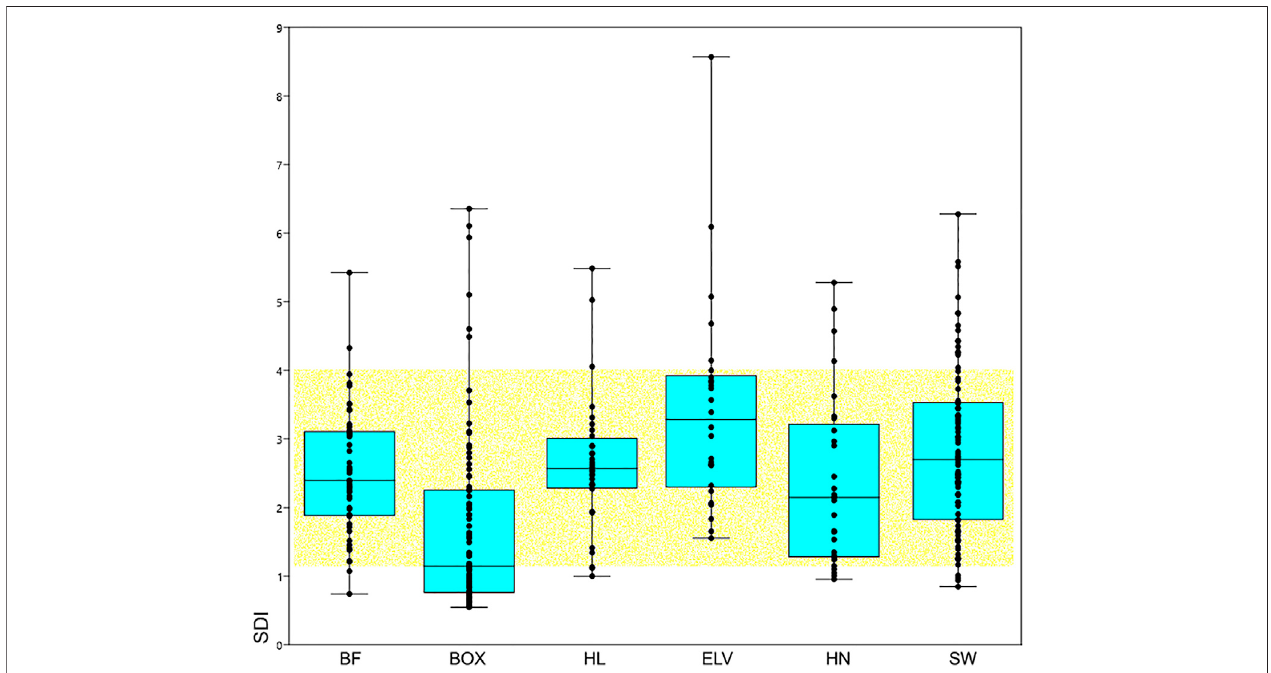
FIGURE 7 | Boxplot with jitter of SDI (scars per in 2 ) distribution per sites. Abbreviations: BF, Brandon Fields; BOX, Boxgrove; HL, High Lodge; ELV, Elveden; HN; Hitchin, SW, Swanscombe.